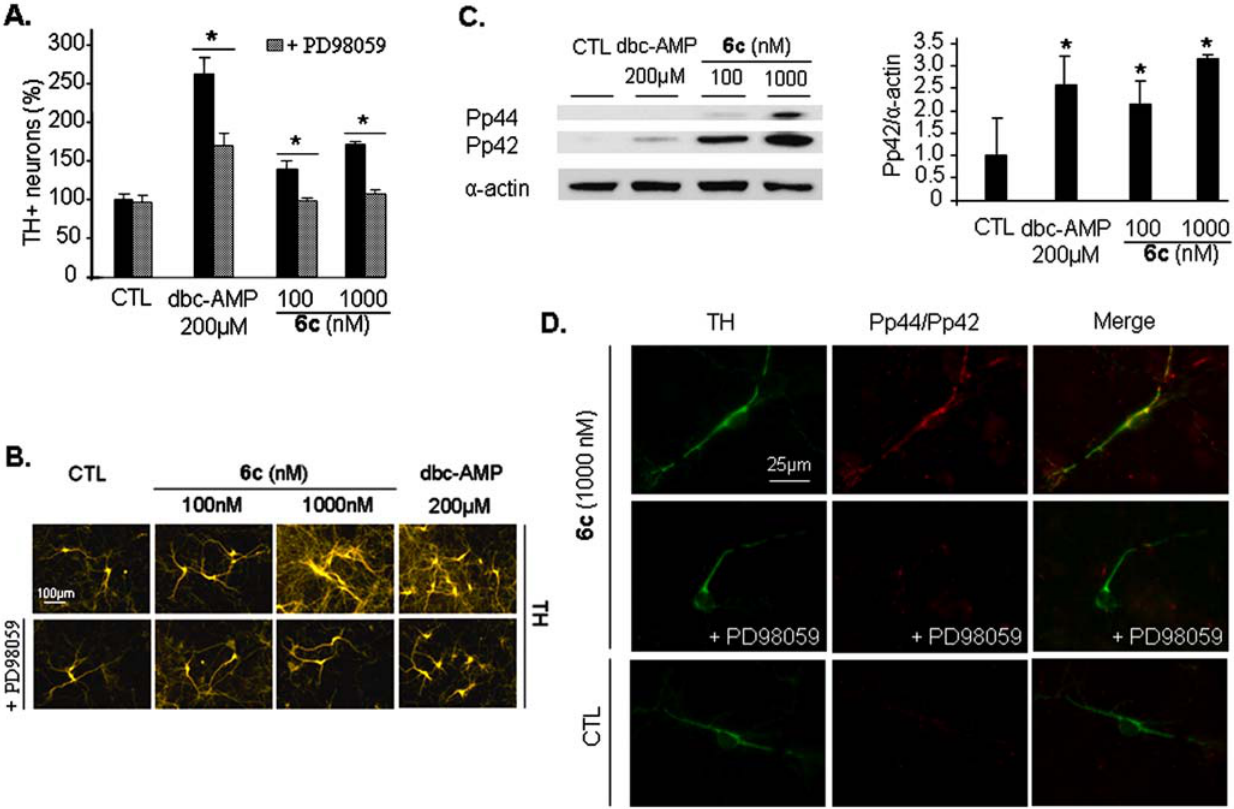
Figure 6. Involvement of extracellular signal-regulated kinase (ERK1/2) activation in compound 6c-induced neurotrophic effect. (A) Addition of PD98059 disrupted the compound 6c-induced neuroprotective effect. Neuronal survival was assessed by counting TH + neurons at DIV12 in 100 or 1000 nM compound 6c-treated cultures in the presence or absence of the MEK inhibitor PD98059 at 10 m M. Dbc-AMP at 200 m M was used as a positive control. Values are normalized to the non-treated control and represent the average of three assays performed in triplicate and expressed as mean 6 SEM. Statistical analysis was performed by two-way ANOVA followed by Duncan’s post hoc test. *P , 0.05. (B) Addition of PD98059 reduced the neuritogenic effect of compound 6c. Images were acquired with an inverted fluorescent microscope coupled to a digital camera. (C) Treatment with compound 6c resulted in an increase of ERK1/2 phosphorylation in a dose-dependent manner. Western blot analyses were performed at DIV12 with proteic lysates from cultures maintained in the presence of compound 6c. Quantification of protein levels was performed with Image J software in at least three independent experiments and is expressed as mean 6 SEM. Statistical analysis was performed by two-way ANOVA followed by Duncan’s post hoc test. *P , 0.05. (D) Visualization of the ERK1/2 phosphorylated forms (Pp44/Pp42) in DA neurons by dual immunolabeling of TH (green) and Pp44/Pp42 (ERK1/2) (red) [48]. Treatment with compound 6c resulted in an increase of ERK1/2 phosphorylated forms in DA neurons. This effect was disrupted by the addition of PD98059 at 10 m M. Images were acquired with unchanged exposure using an inverted fluorescent microscope coupled to a digital camera. Merge were performed using image analysis software.